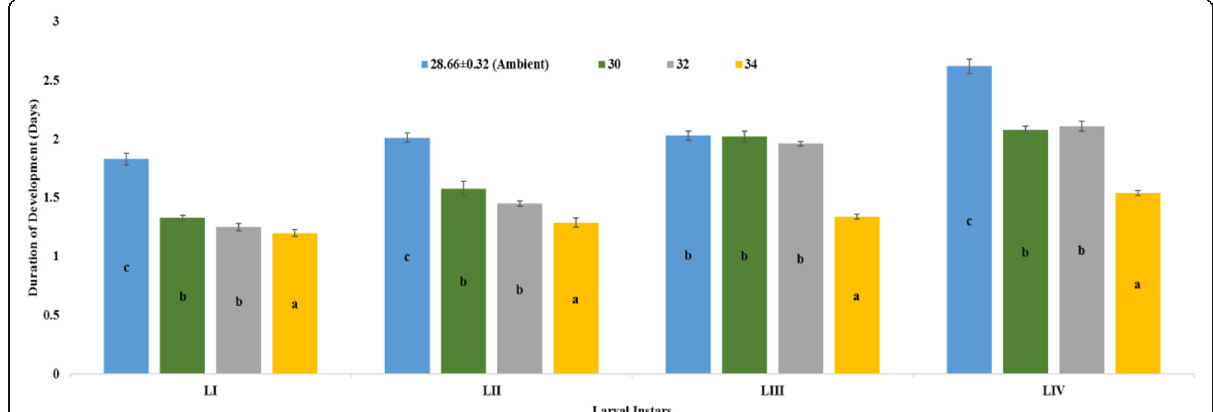
Fig. 1 Effects of rearing-water temperature on duration of development of larval instars (LI – IV) of Culex quinquefasciatus mosquito. Temperature bars with same letter at each larval instar are not significantly different at p < 0.05 according to analysis of variance. Values are expressed as mean ± standard deviation (mean ± SD)